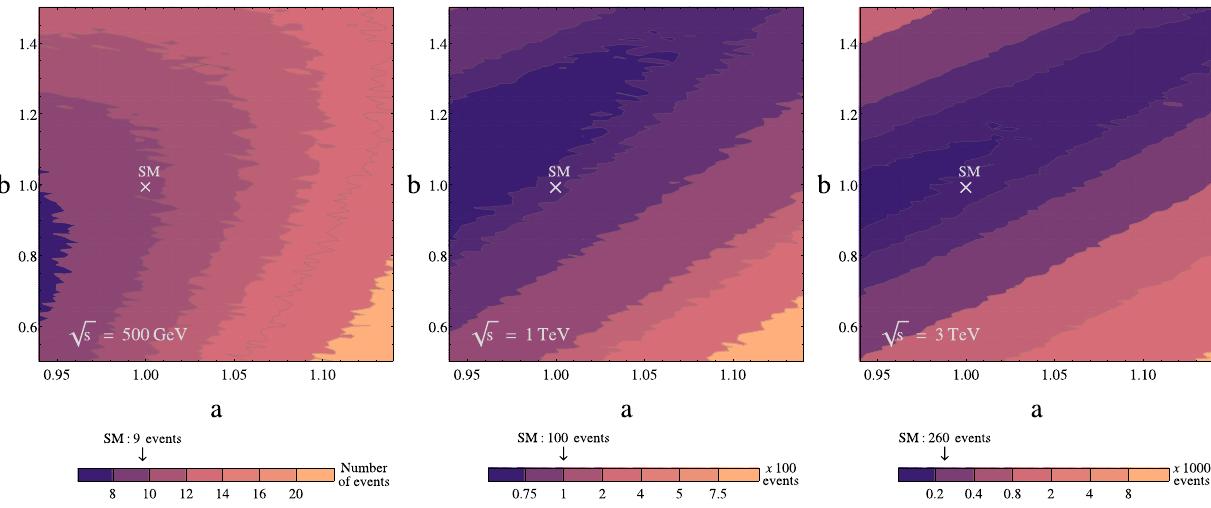
Fig. 28 Contour lines for the expected number of events of the e + e − → H H ν e ¯ ν e → b ¯ bb ¯ b ν e ¯ ν e process in the ( a , b ) plane. The cuts in Eq. (13) and the efficiency factors have already been implemented, see text for details. Several collider stages are considered: ILC with 500